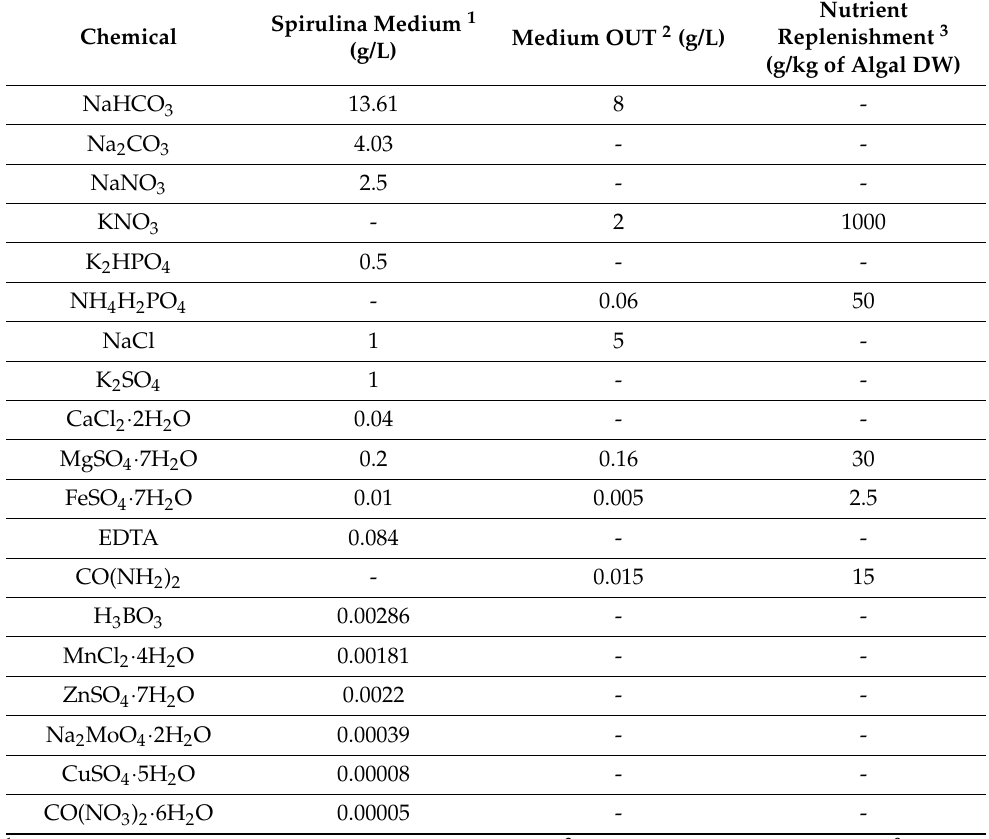
Table 1. Chemical composition of the culture media used for the maintenance of A. platensis BEA 1257B in growth chamber (Spirulina medium), and for the scaling-up and outdoor cultivation under greenhouse conditions (medium OUT). A fresh medium recipe was used during the experimental F phase (12-Sep. to 11-Oct.), whereas nutrient replenishment was applied during the R phase (11-Oct. to